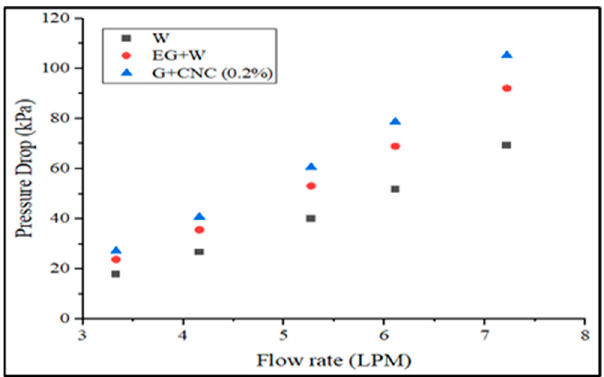
Figure 11. Pressure drop (kPa) vs. flow rate in LPM.